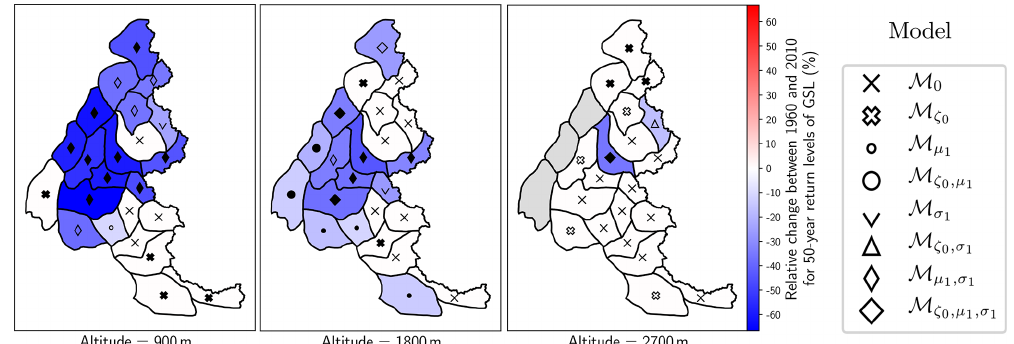
Figure 5. Trends in 50-year return levels of ground snow load (GSL) between 1960 and 2010 at low (900m), mid (1800m) or high (2700m) altitude. Markers show selected model M N , while filled markers symbolize models that are significantly better than the Gumbel model M 0 (Sect. 4.2). Grey areas denote missing data, e.g. when the altitude considered is above the top altitude of the massif.